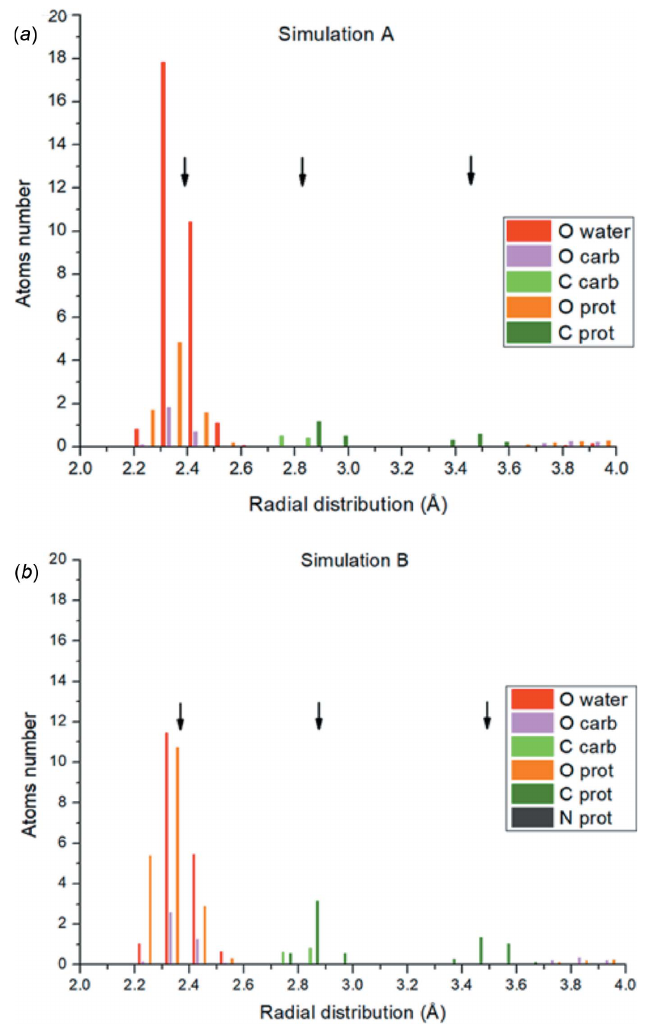
Figure 3 Sum of the radial distribution functions for each type of neighbour for the six Pu atoms for simulations A and B. Each vertical bar corresponds to the number of neighbors that occur at the same distance within 0.02 A˚ difference. The average for the first Pu—O shell and the second and third Pu—C shells are represented with a vertical black arrow (average of all Pu